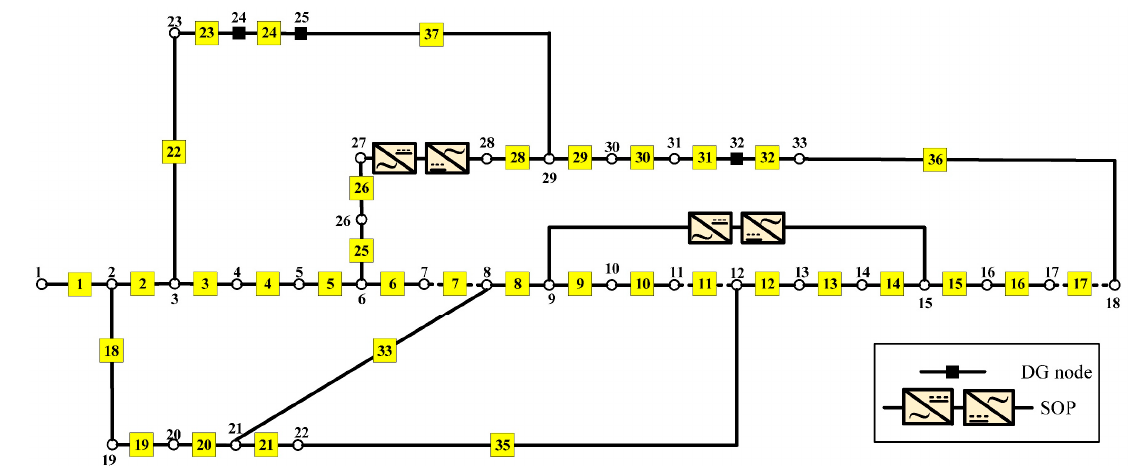
Figure A1. IEEE 33-node distribution system after NR, SOPs, and DGs allocation with SOPs internal losses considered: scenario 9.